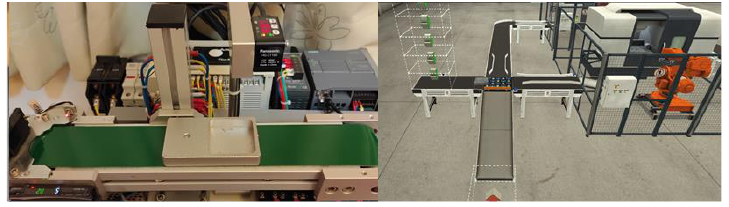
Figure 11. The feeding mode including physical mechanism and warehouse